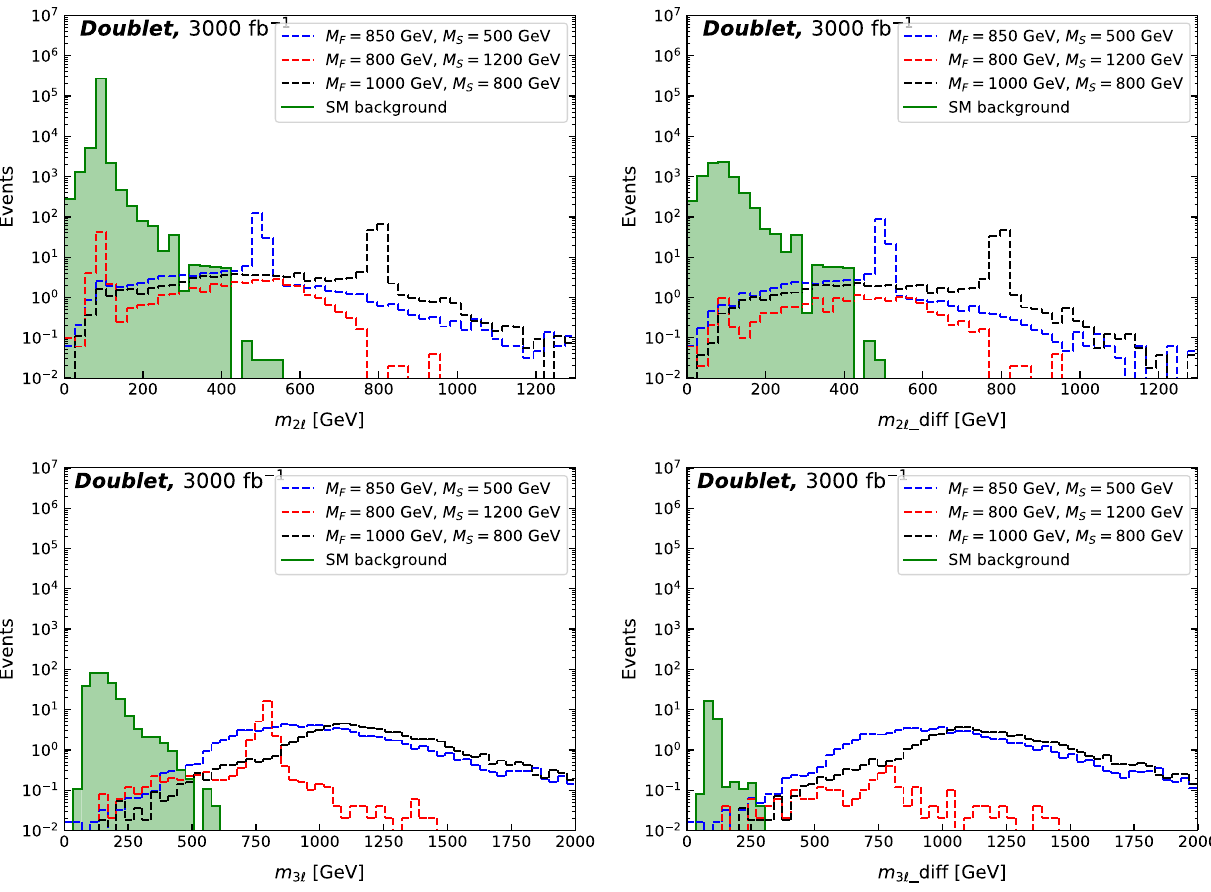
Fig. 17 Di- and trilepton invariant mass distributions m 2 (cid:5) , m 2 (cid:5) _diff, m 3 (cid:5) , and m 3 (cid:5) _diff after detector simulation for the doublet model. The observables are shown for different benchmarks of VLLs and BSM scalar masses at a luminosity of 3000 fb − 1 and is fixed according to Eq.